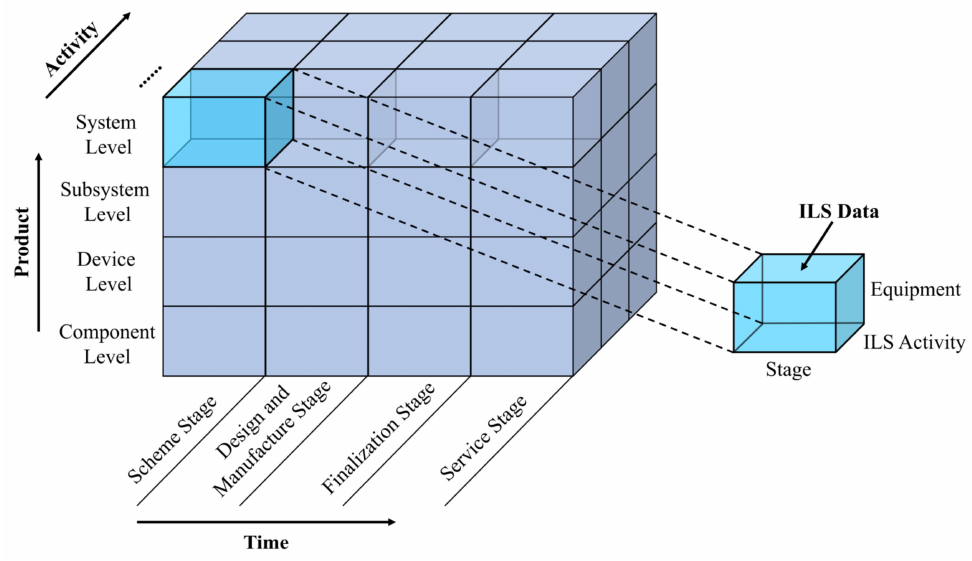
Figure 7. Three-dimensional representation of ILS data based on the Domain unified data